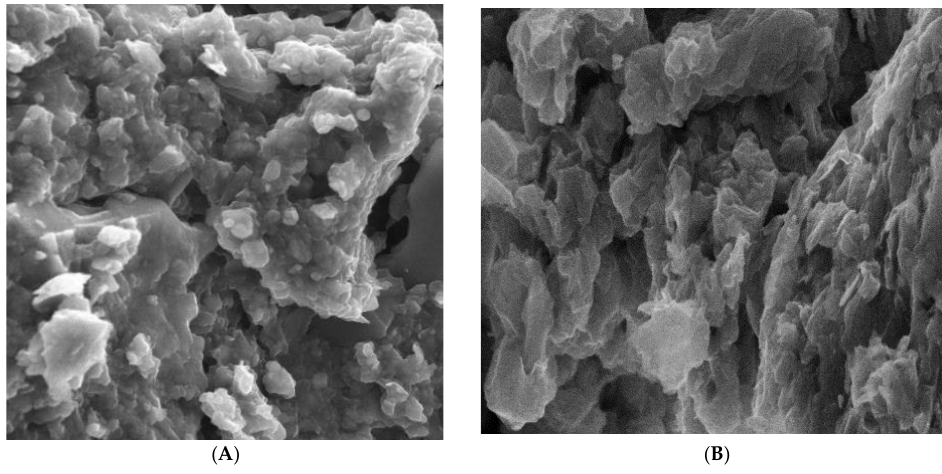
Figure 4. SEM images of GO ( A ) and Zr-GO ( B ).